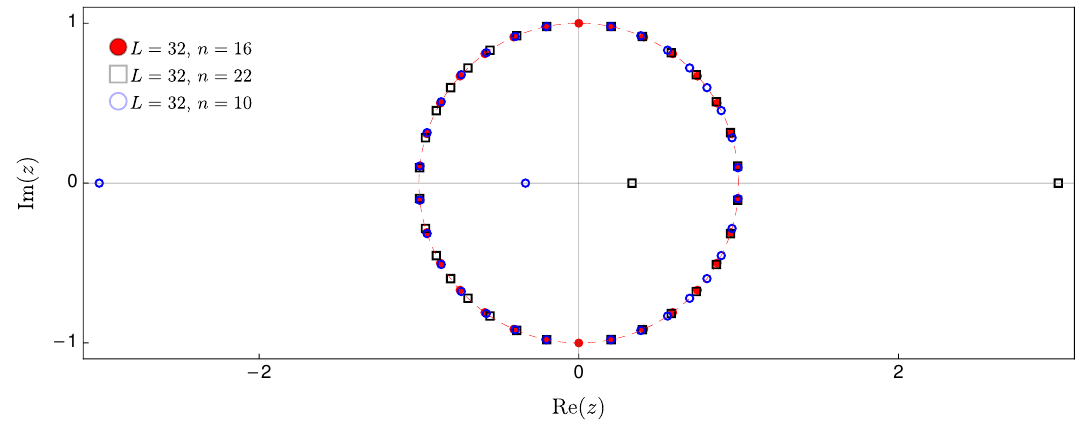
Figure 12: Solutions of the equation (211) for N = 12 and n = 4,6,8. All of the solutions lie on the unit circle (red dashed line) except for two solutions at any n , if n (cid:54) = N /